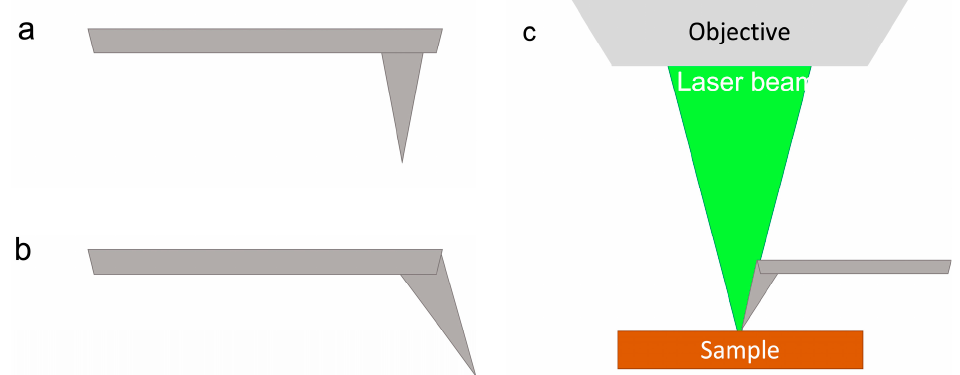
Figure 1. Sketch of ( a ) the usual tip geometry, ( b ) the special tip geometry optimized to acquire the Raman-AFM combined measurement; ( c ) axial coupling between the Raman system and the AFM set up, which highlights the special tip.